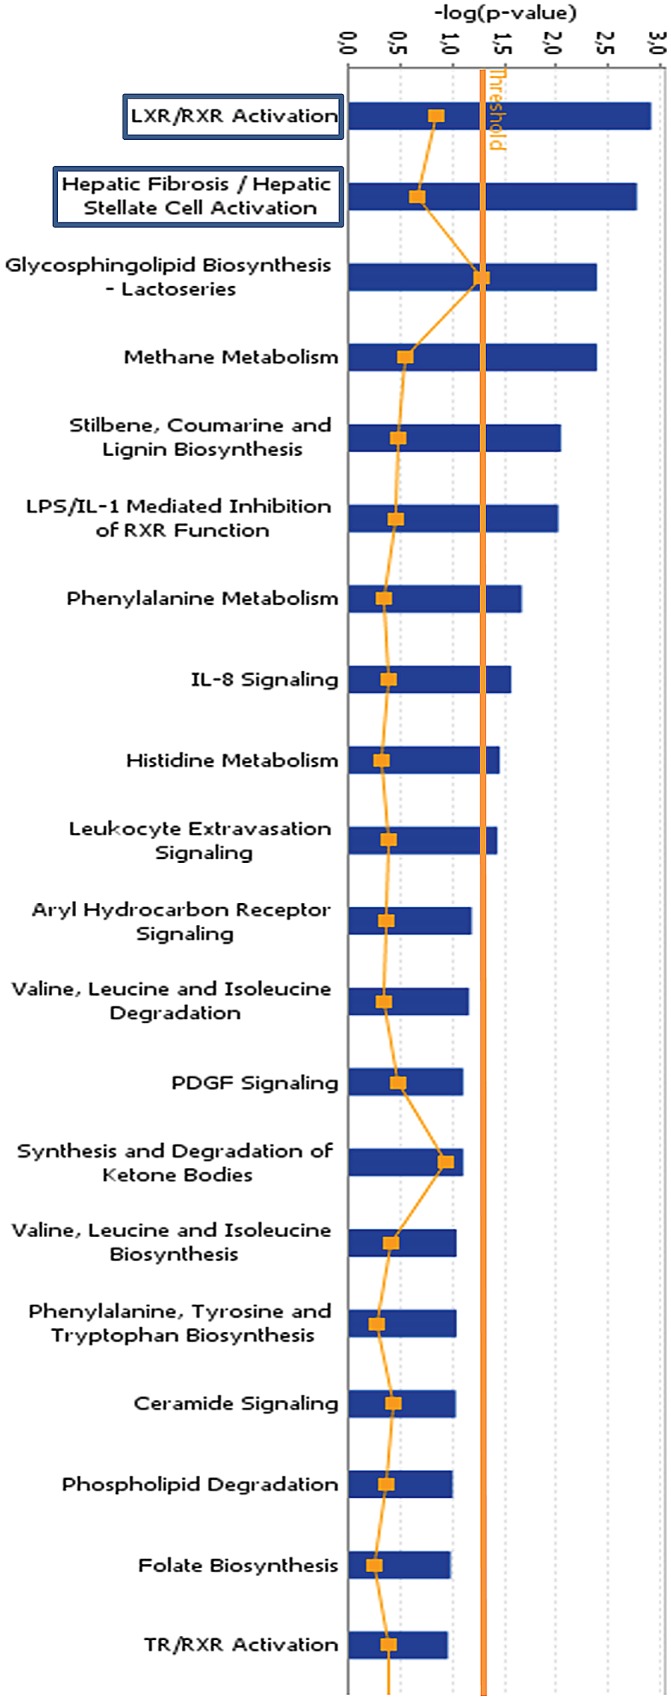
Canonical pathway analysis.The canonical pathways most enriched in FCMs were anti-inflammatory (LXR) and pro-fibrotic (derived from array data). Blue bars indicate significance, orange line indicates ratio. (Ingenuity Systems Inc).